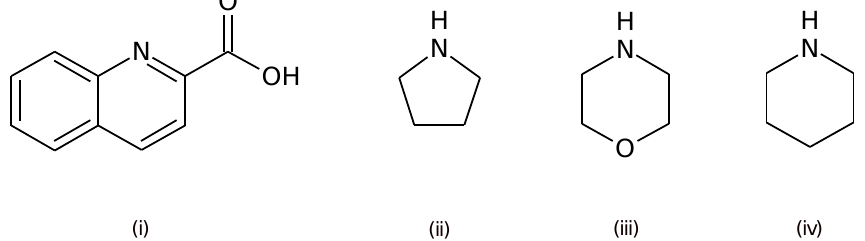
Scheme 1. Structural formulae of the ligands used in this work: (i) Quinaldinic acid, (ii) pyrrolidine, (iii) morpholine, and (iv)